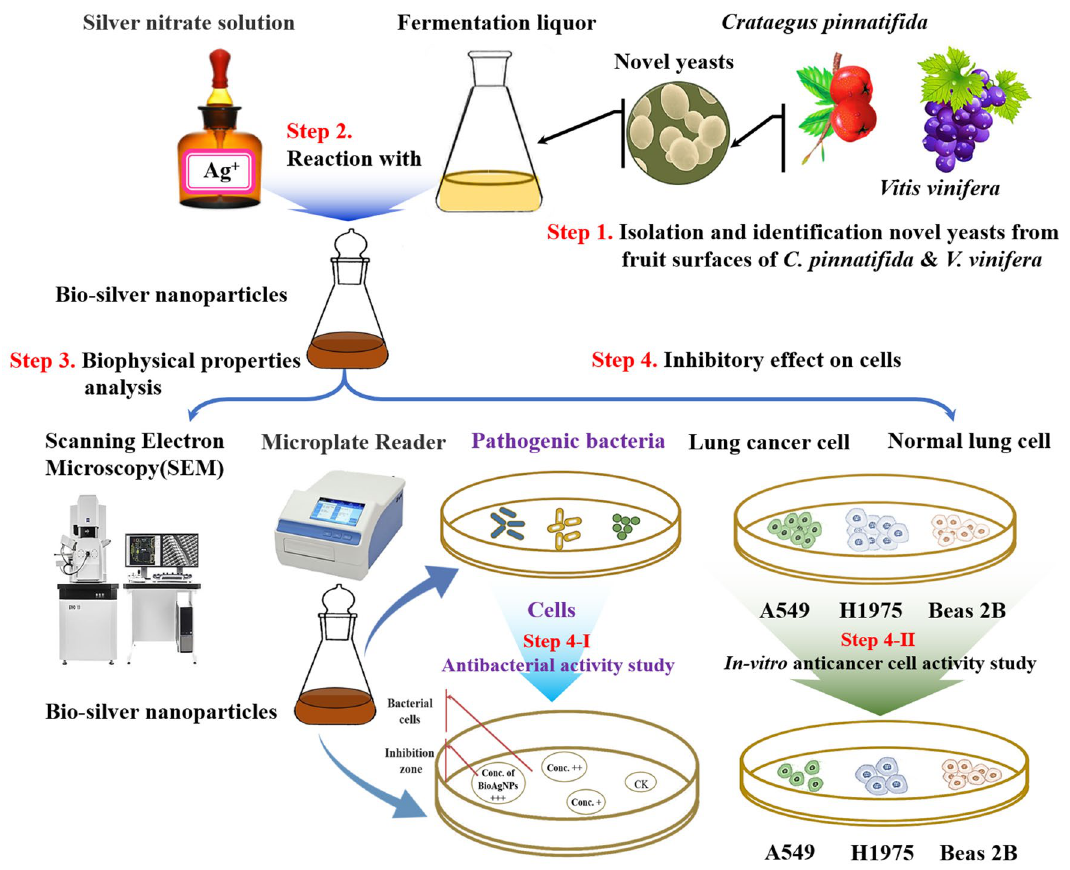
Figure 1. Schematic illustration of experimental process in this